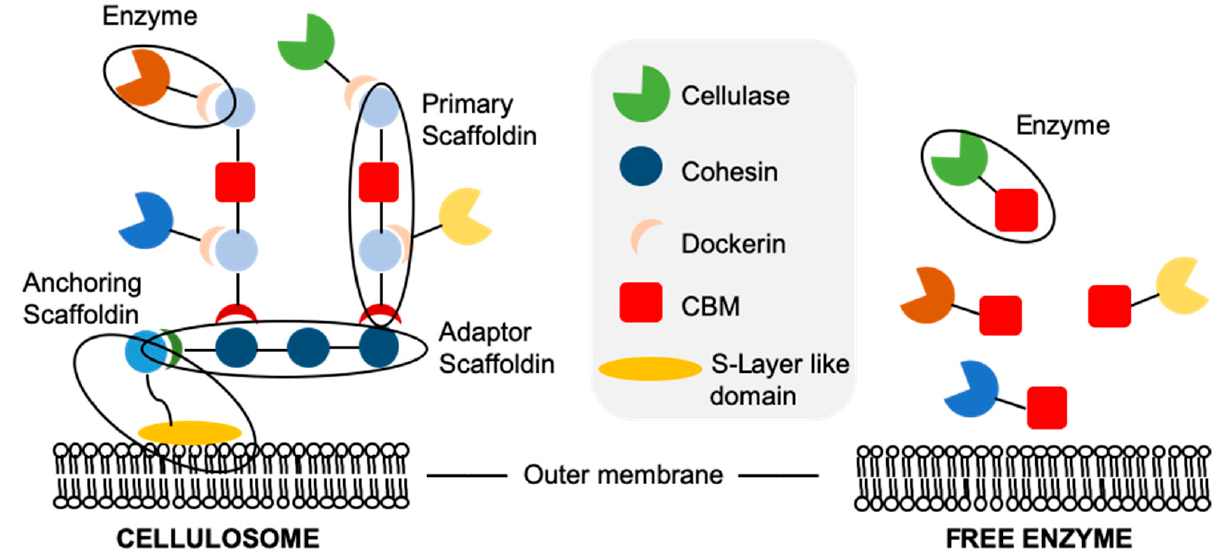
Figure 3. Schematic representation of free cellulases and cellulosomes.